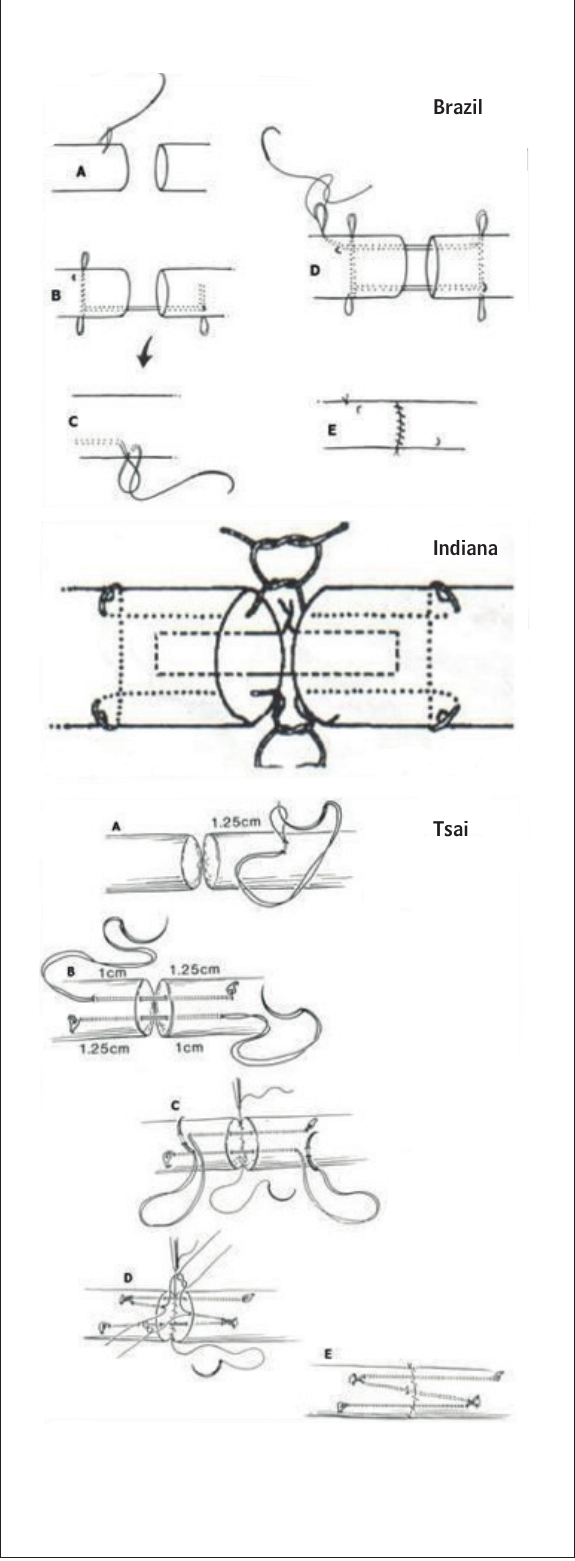
Figure 1 - Diagram of suture techniques: Brasil, Indiana and